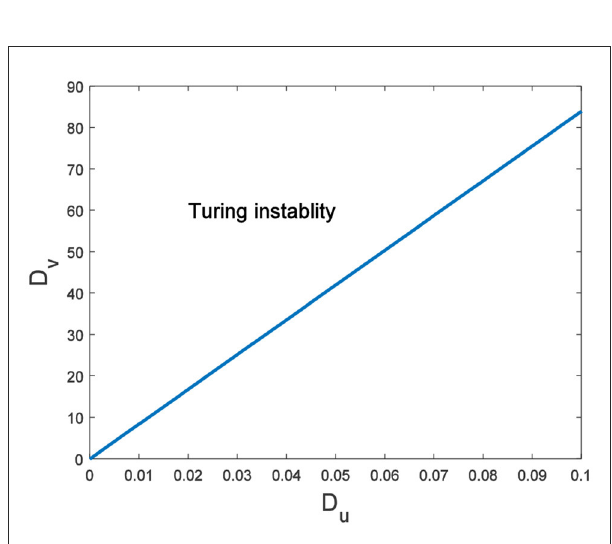
1, b 1, c 2, d 1, I 0.7. = = = = =